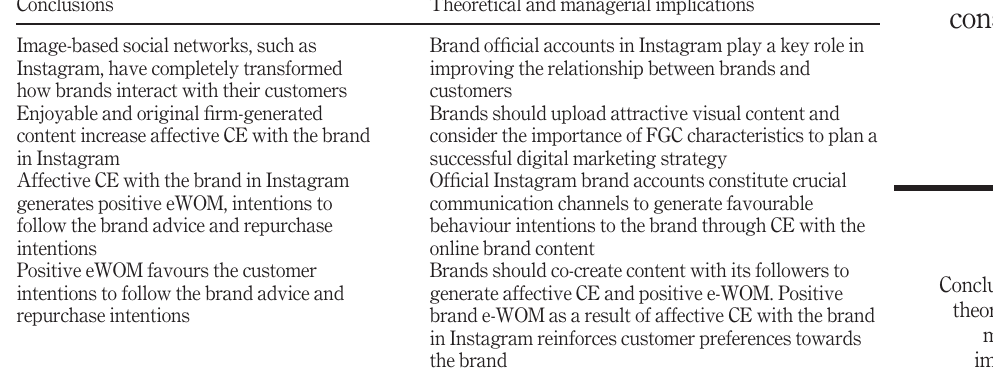
Table 4. Conclusions